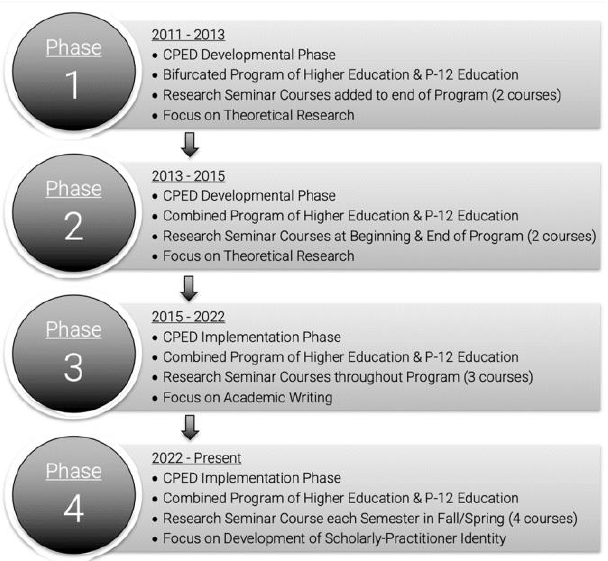
Figure 1. The Phases of the Redesign of the EdD Program Since the Phase 1 Design in 2011